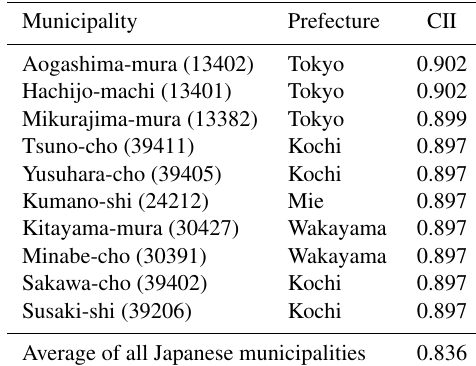
Table 3. Same as Table 2 but for the average CII for the 30 high-CII